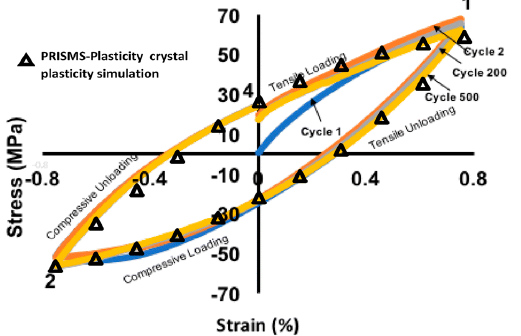
Figure 33. The stress ‐ strain response of pure Mg sample during cyclic loading along the extrusion direction: CPFE simulation results for cycle 2 ( Δ symbol) are compared versus the experimental results (After Aagesen et al. [108]).